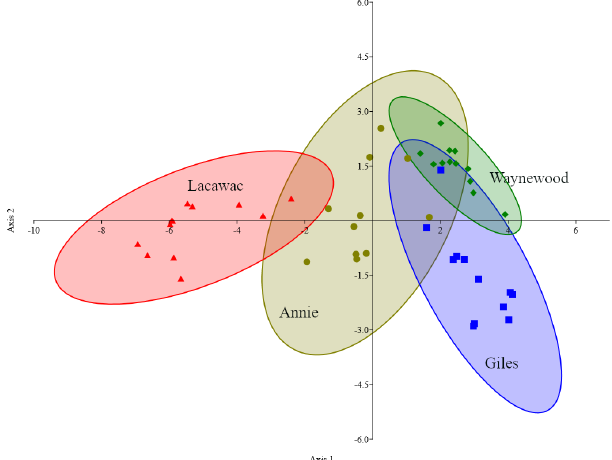
Figure 3. Canonical plot scores and 95% confidence ellipses from descriptive discriminant analysis of the measured changes (i.e.„ treatment minus control) in the five variables (DOC, DIC, DO, SUVA 320 , and S r ) and four lakes, namely Annie (olive circles), Giles (blue squares), Lacawac (red triangles), and Waynewood (green diamonds). Only photodegradation samples were included in this